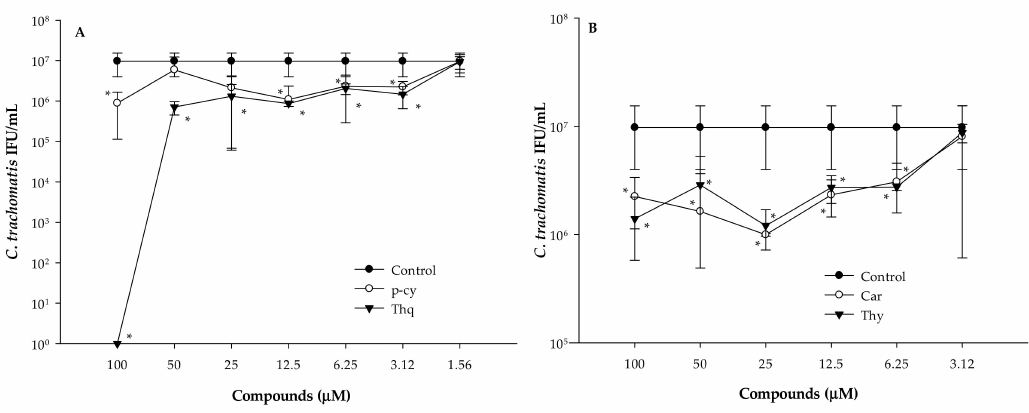
Figure 3. Inhibitory e ff ects of the bioactive compounds of N. sativa EO on C. trachomatis D at di ff erent concentrations evaluated by direct quantitative PCR. HeLa cells infected with C. trachomatis D alone were used as controls. ( A ) p-cy: p-cymene; Thq: thymoquinone; ( B ) Car: carvacrol; Thy: thymol; * p <